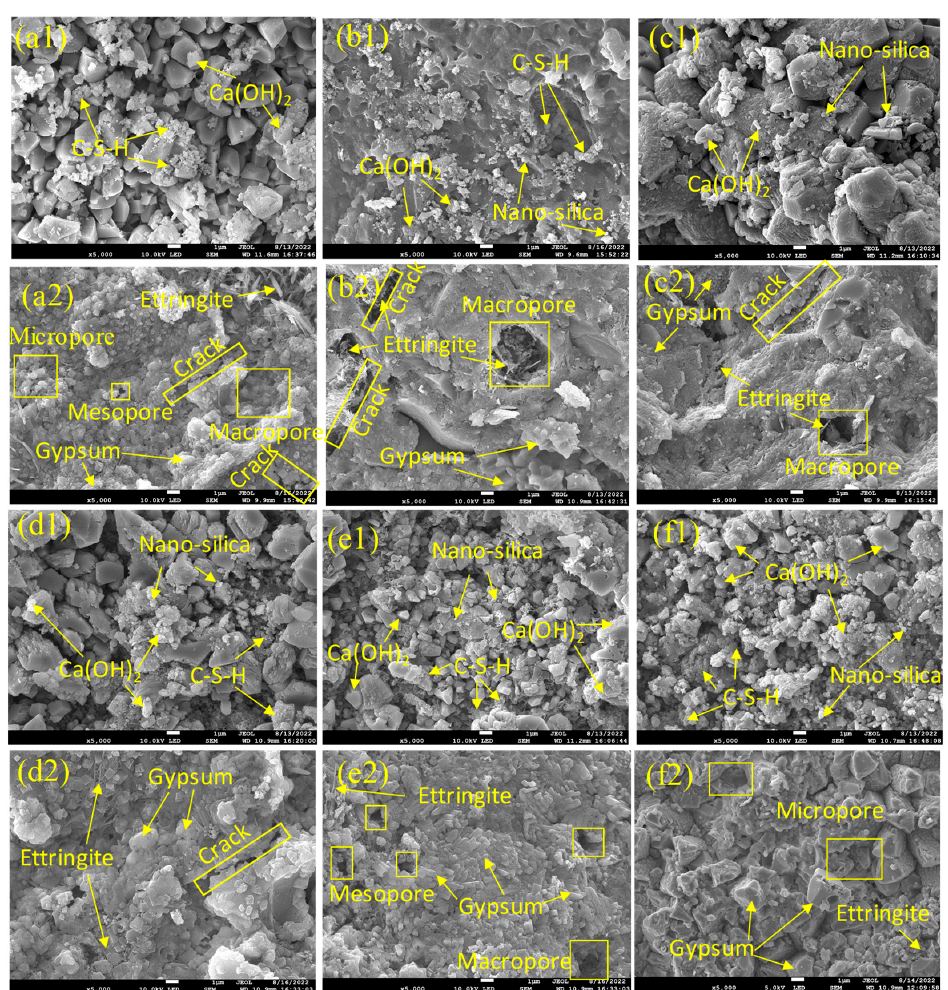
Figure 10. The SEM images of HPC specimens before ( a1 – f1 ) and after ( a2 – f2 ) sulfate attack. ( a1 , a2 ), 0% Nano-silica; ( b1 , b2 ), 1% Nano-silica; ( c1 , c2 ), 2% Nano-silica; ( d1 , d2 ), 3% Nano-silica; ( e1 , e2 ), 4% Nano-silica; ( f1 , f2 ), 5% Nano-silica. The minerals were determined based on the EDS chemical